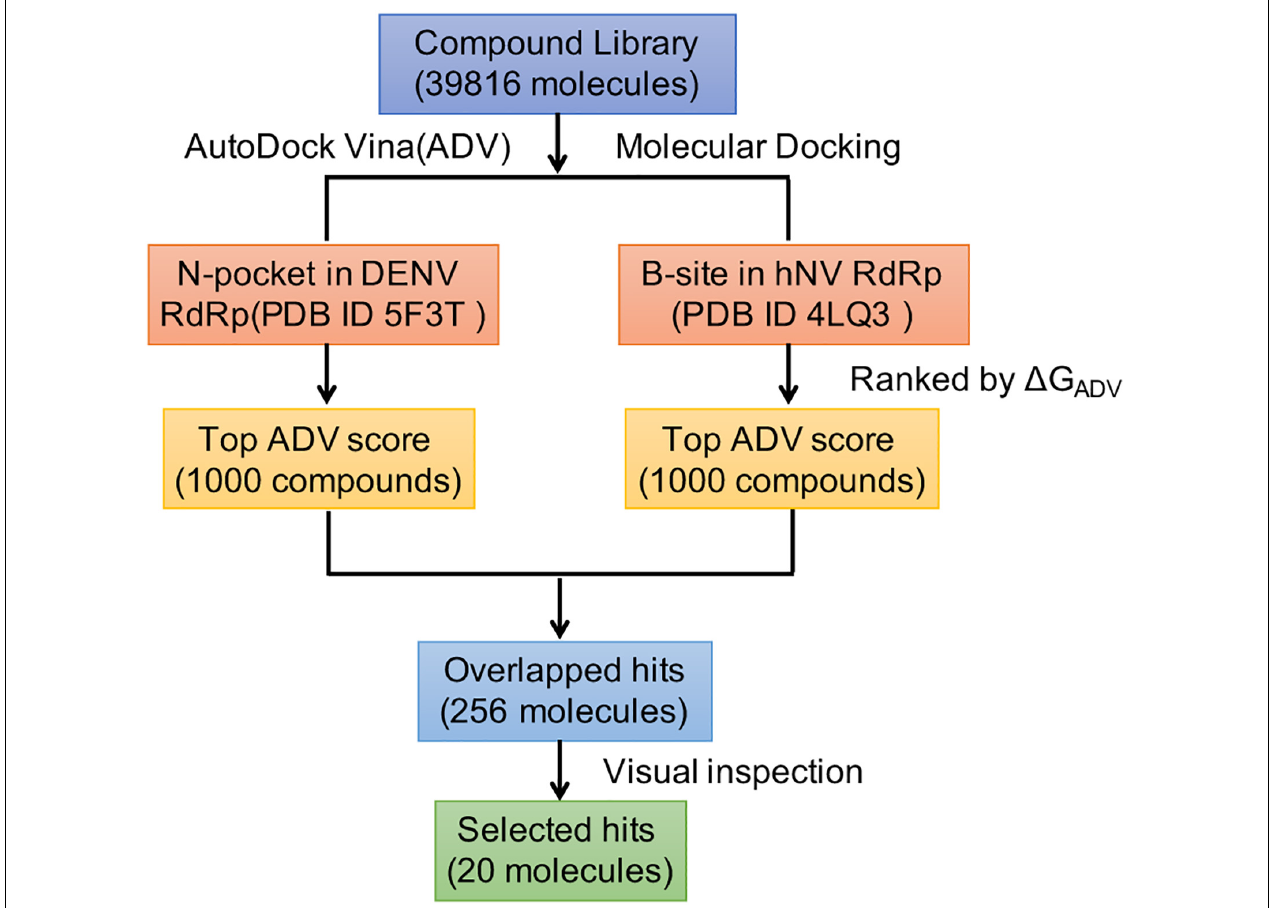
FIGURE 2 | Overall workflow of the structure based virtual screening for identification of inhibitors targeting DENV and hNV RdRps.